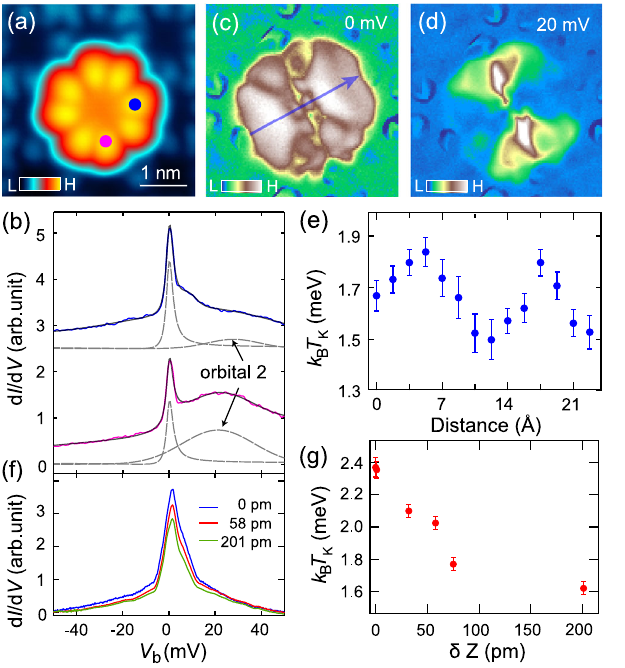
Fig. 2 | Kondo effect of Tb 2 Pc 3 . a STM image ( V = − 1.0V and I =10 pA) of an imbedded type-1 Tb 2 Pc 3 . b Tunneling spectra ( V =50mV and I =100 pA) taken at locations indicated in ( a ) at 2T, showing Kondo resonances and the upper LUMO. The fi ttingcurvesareshowningray. c , d d I /d V mappingof( a )takenattheindicated energies. e Variationoftheresonancewidthextractedfromthespectratakenalong the blue arrow in ( c ). f Tunneling spectra taken at the same location of a Tb 2 Pc 3 , showing evolution of the Kondo resonance with decreasing tip height δ Z , where δ Z = 0pm is set at V =5mV and I =50 pA. g The Kondo peak width extracted from ( a ) as a function of δ Z .